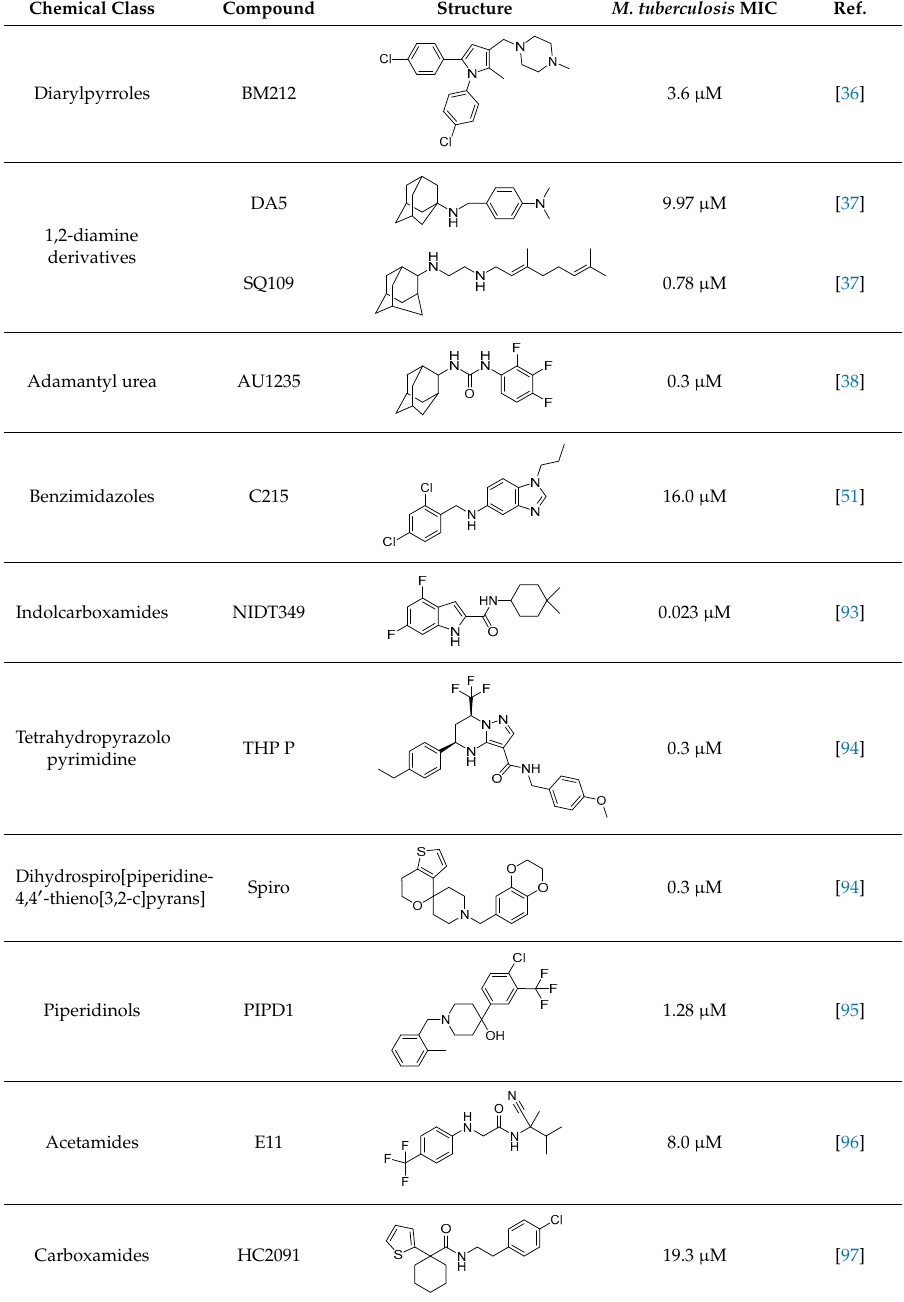
Table 2. Main MmpL3 inhibitors showing antitubercular activity.